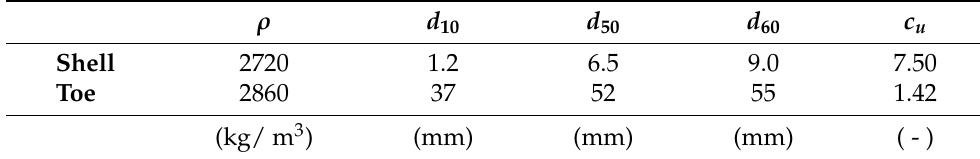
Table 2. Material properties for shell and